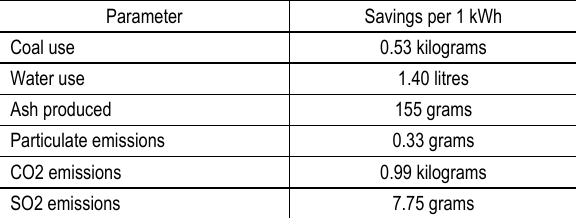
Table 2. SWH environmental